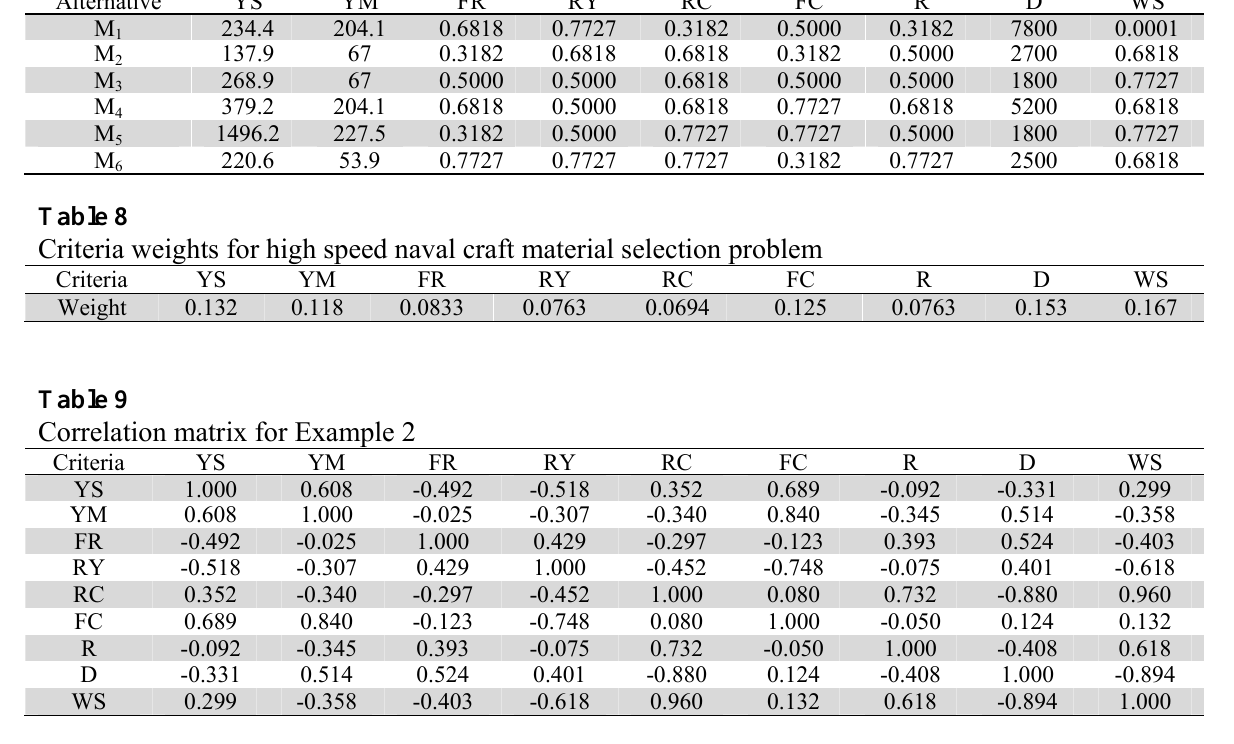
Decision matrix for high speed naval craft material selection problem (Rao & Patel, 2010) Alternative YS YM FR RY